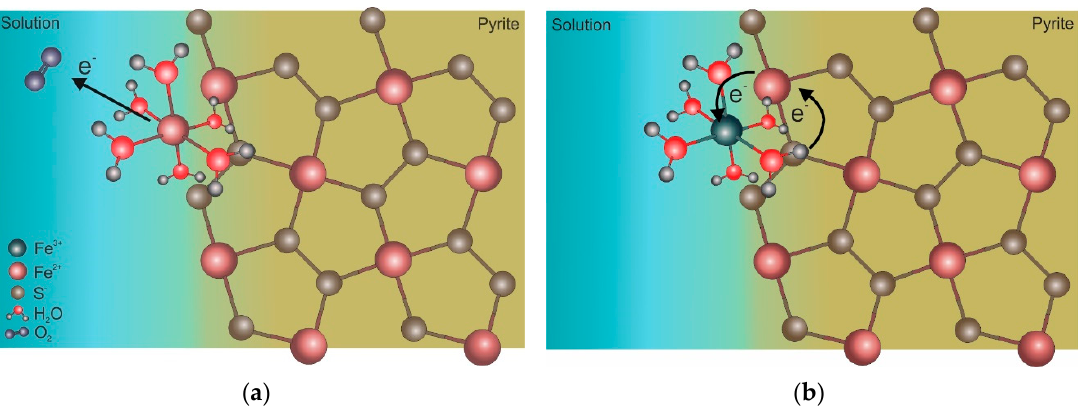
Figure 3. Illustration of the abiotic oxidation mechanism of pyrite. The adsorption of released Fe 2 + from pyrite as aqueous Fe 2 + (H 2 O) 6 is the first step of pyrite oxidation. ( a ) The oxidation of Fe 2 + (H 2 O) 6 complex by the dissolved molecular oxygen forms ( b ) Fe 3 + that accepts electron from the pyrite during its oxidation.